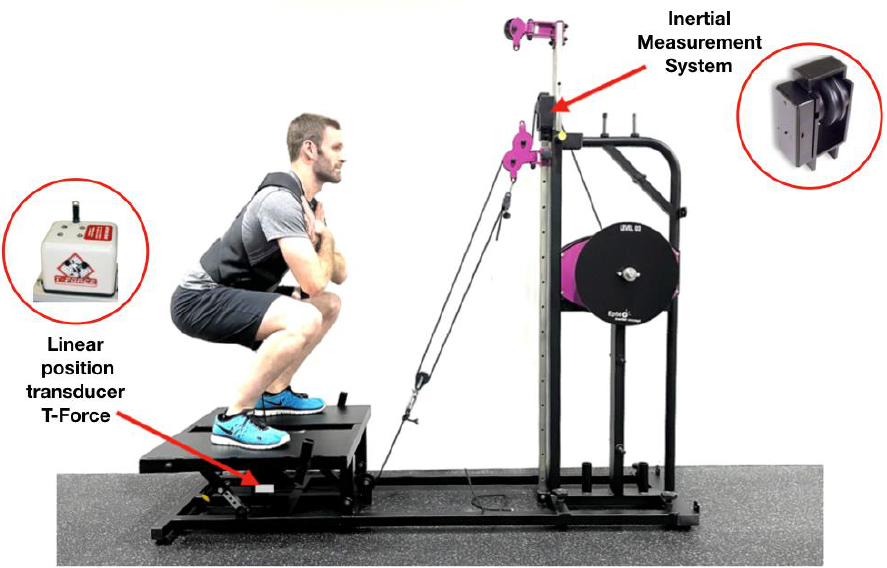
Figure 1. Squat exercise on the Epte Inertial Concept with a linear position transducer (LPT) and an Inertial Measurement System (IMS).